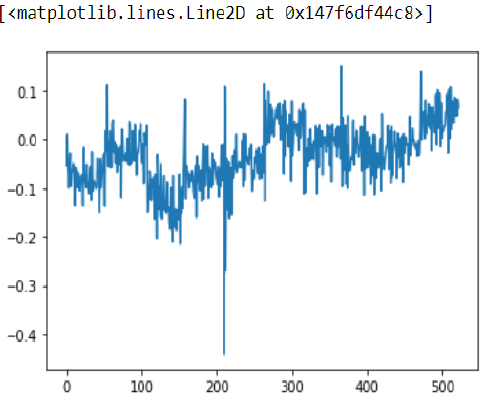
Figure 56. Merged acceleration data visualization.